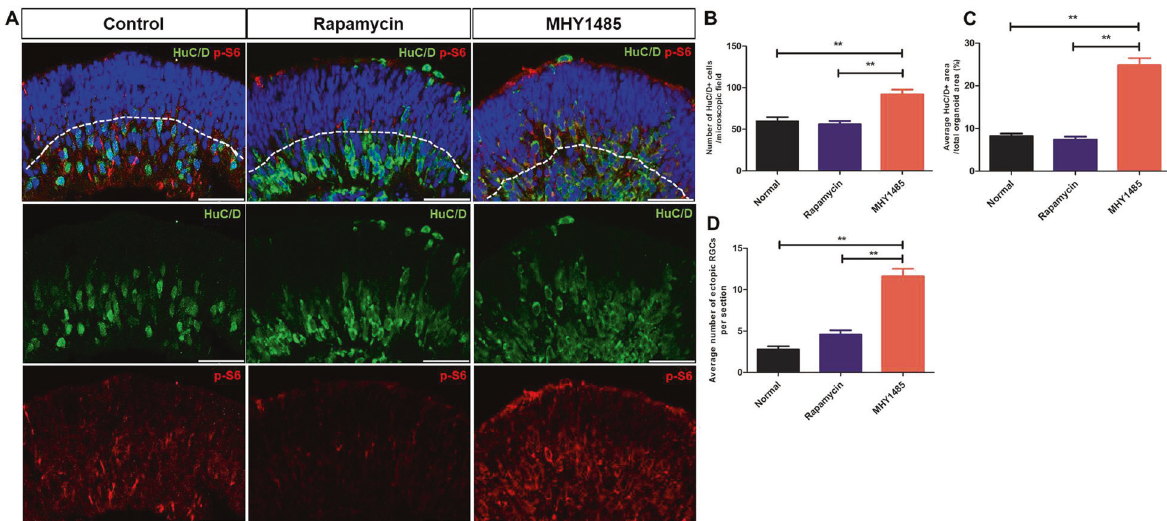
Fig. 6 RGC development and retinal lamination in ROs at 50 days of differentiation after rapamycin or MHY1485 treatment. A RGC development in control, rapamycin-treated, and MHY1485-treated ROs shown by immunostaining of HuC/D (green) and p-S6 (red) at 50 days of differentiation. B – D Quanti fi cation of the ratio of average HuC/D area, number of HuC/D positive cells, and number of displaced RGCs in control, rapamycin-treated, and MHY1485-treated ROs. Data are expressed by mean ± S.E.M. ** p < 0.01, by the Kruskal – Wallis test with post hoc analysis. Scale bar: 50 μ m.